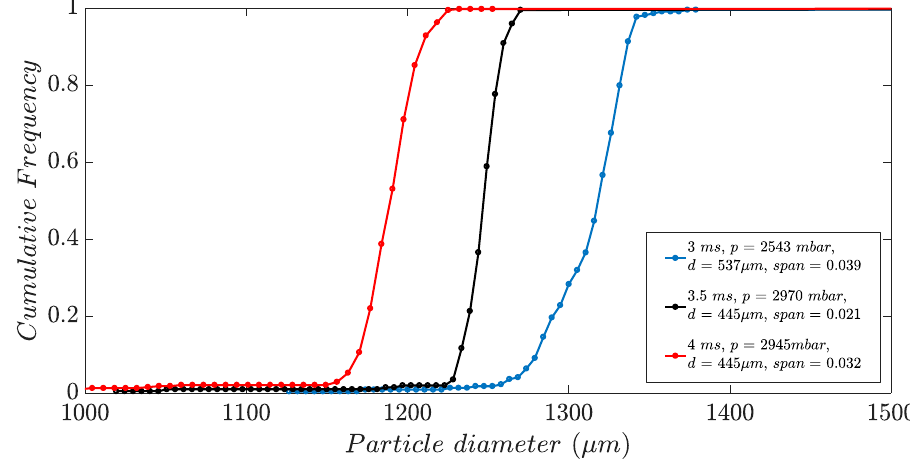
ff erent process